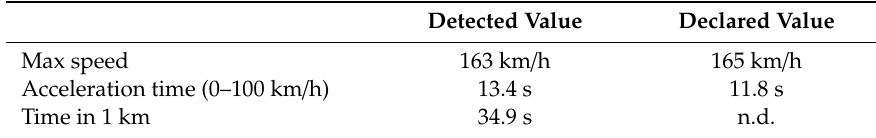
Table 20. Commercial HV